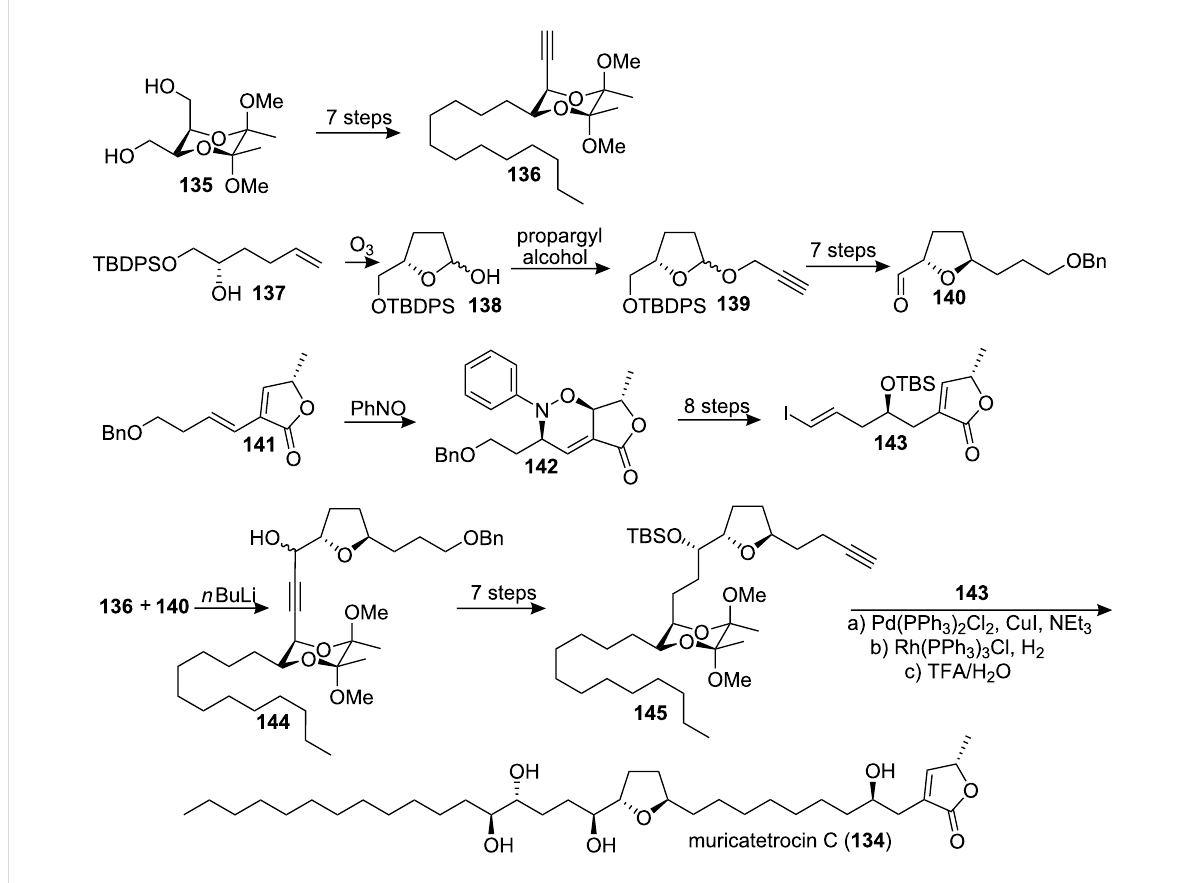
Scheme 20: Total synthesis of muricatetrocin C by Ley’s